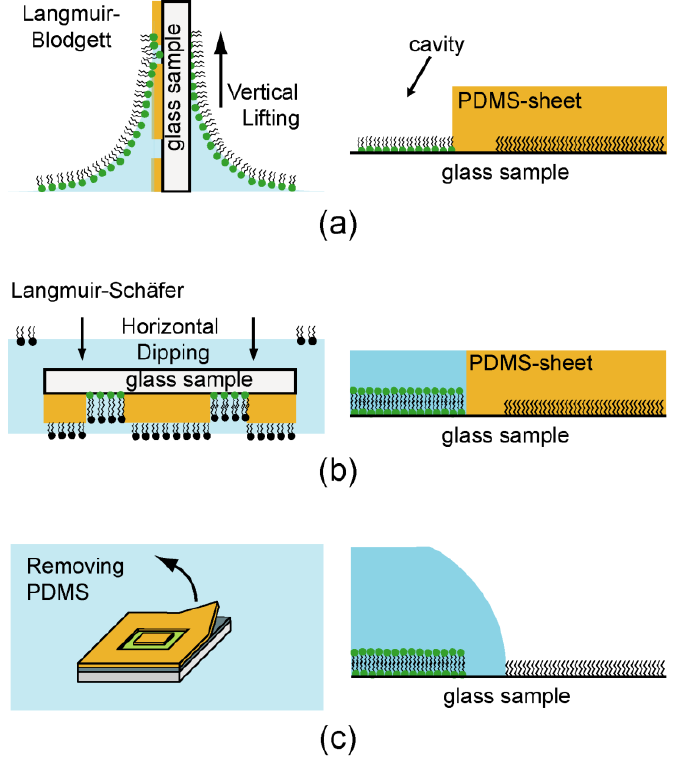
surface (width ~200 2